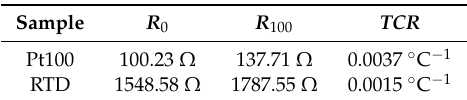
Table 2. Resistance values at 0 ◦ C ( R 0 ) and 100 ◦ C ( R 100 ) for RTD and commercial Pt100. The calculated TCR value is also included.